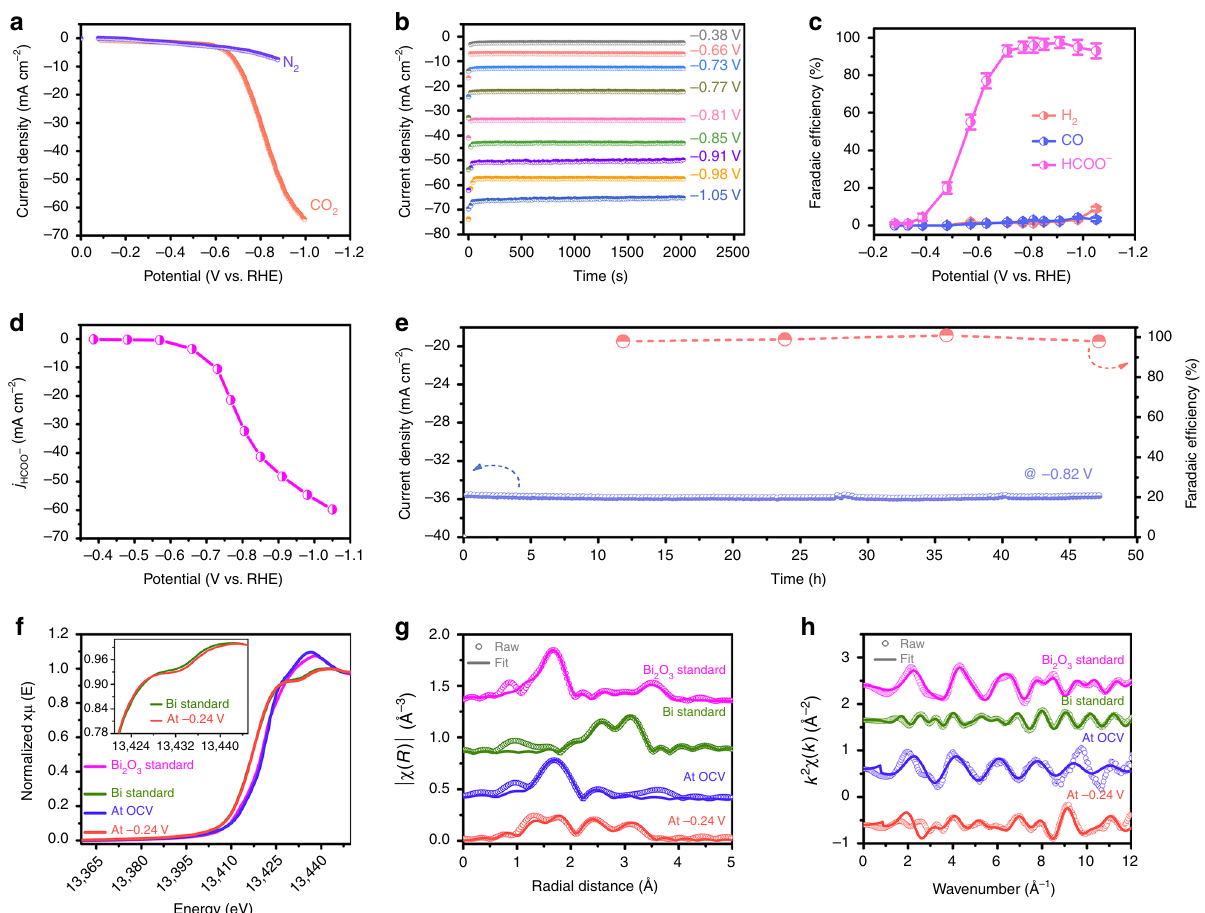
Fig. 2 Electrochemical carbon dioxide reduction measurements in the H-type cell. a Polarization curves of nanotube-derived Bi (NTD-Bi) in CO 2 or N 2 - saturated electrolytes. b Chronoamperometric responses in CO 2 -saturated electrolyte at different potentials as indicated. c Potential-dependent Faradaic ef fi ciencies of HCOO − , CO, and H 2 . d Formate partial current density derived from ( b ) and ( c ). e Long-term amperometric stability and corresponding selectivity change at − 0.82 V. f Operando Bi L-edge XANES spectra of Bi 2 O 3 nanotubes (NTs) at OCV and NTD-Bi at − 0.24V in comparison with Bi or Bi 2 O 3 standards; inset plot is the partially enlarged spectra. g , h Fitting results of the operando EXAFS spectra to ( g ) R space and ( h ) K